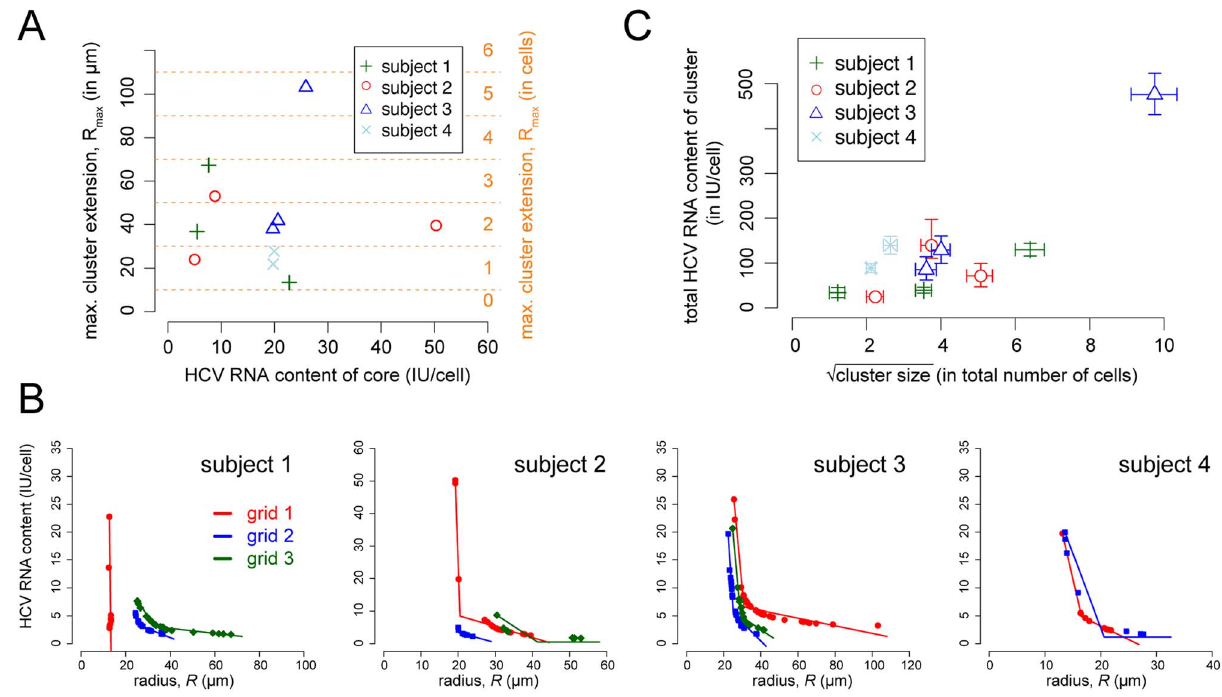
Figure 3. Relationship between cluster extension and HCV RNA content. ( A ) The maximal extension of the clusters, R max , characterized on the different grids in relation to the maximal cellular HCV RNA content in the cells belonging to this cluster. For each grid, only the clusters including the cell with the highest amount of intracellular HCV RNA were considered. Different patients are indicated by different symbols and colors. The radius R is given on a continuous scale, as well as converted into number of cells assuming radial spread. ( B ) The level of the HCV RNA content in hepatocytes with increasing cluster extension as characterized by Fig. 2. Dots correspond to the radii estimated during the iterative process of cluster determination. The individual results for all patients and all different sections per patient (grid 1 red , grid 2 blue , grid 3 green ) are shown. Lines indicate the best fit of a model assuming a biphasic linear decrease of the intracellular HCV RNA content with increasing cluster extension (see Table 4). ( C ) The total HCV RNA content in an inferred cluster, i.e., the sum of the HCV RNA content in all hepatocytes belonging to a cluster versus the square root of the cluster size measured in number of cells. Each point is the result of 10,000 simulated clusters based on the characteristics for each of the different clusters per patient per grid as described in Materials & Methods . Symbols indicate the mean of total HCV RNA content and cluster size, arrows determine the 2.5% and 97.5% percentiles of the 10,000 bootstrap replicates. Corresponding values are given in Table 1.